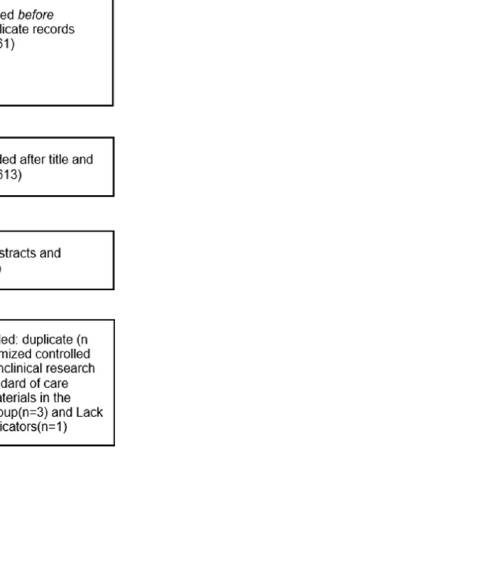
Fig 1. Screening flowchart for the included